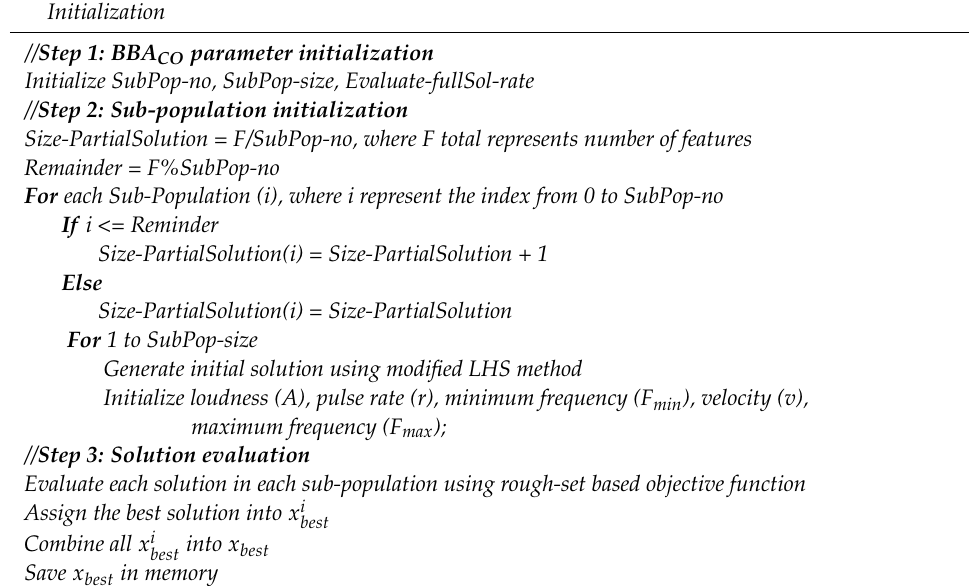
Algorithm 1. Pseudocode of the initialization stage.